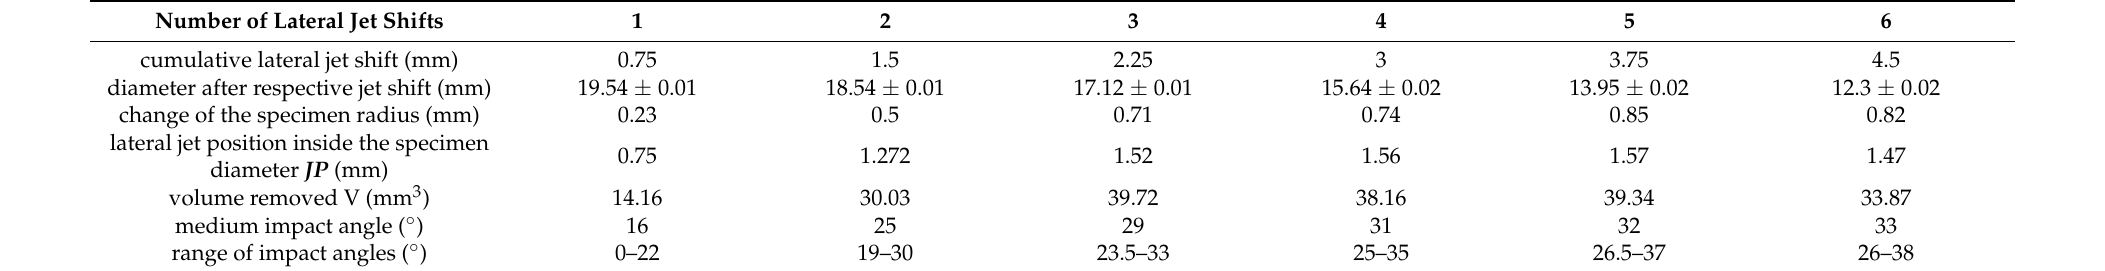
Table 9. Experimental results with the lateral jet shift 0.75 mm.